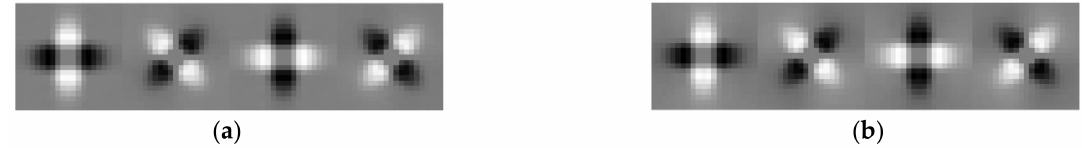
Figure 9. Equivalent feature extractors t θ ( m , n ) of the old PCA-based detector [14], for orientations θ ∈ {0 ◦ , 45 ◦ , 90 ◦ , 135 ◦ }, in the Cx channel ( a ) and Cz channel ( b